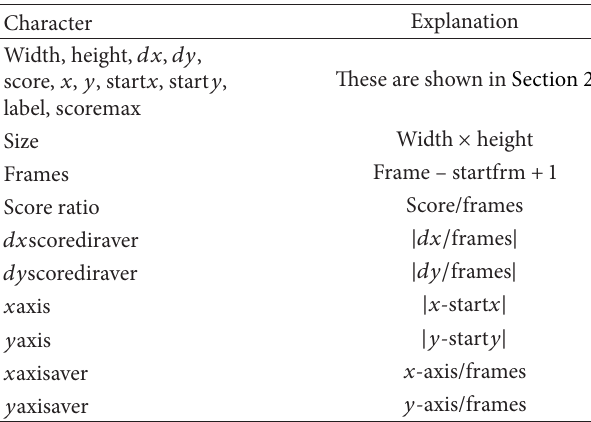
Table 3: All fields in a